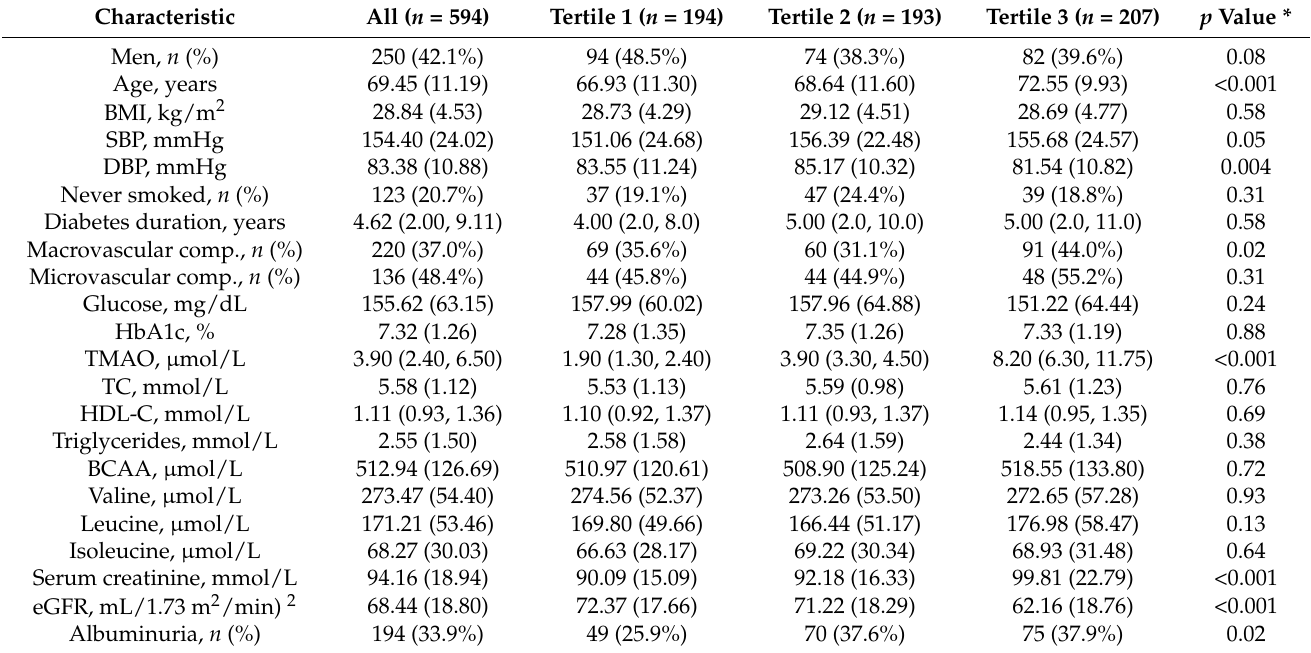
Table 1. Baseline participant characteristics according to tertiles of plasma TMAO